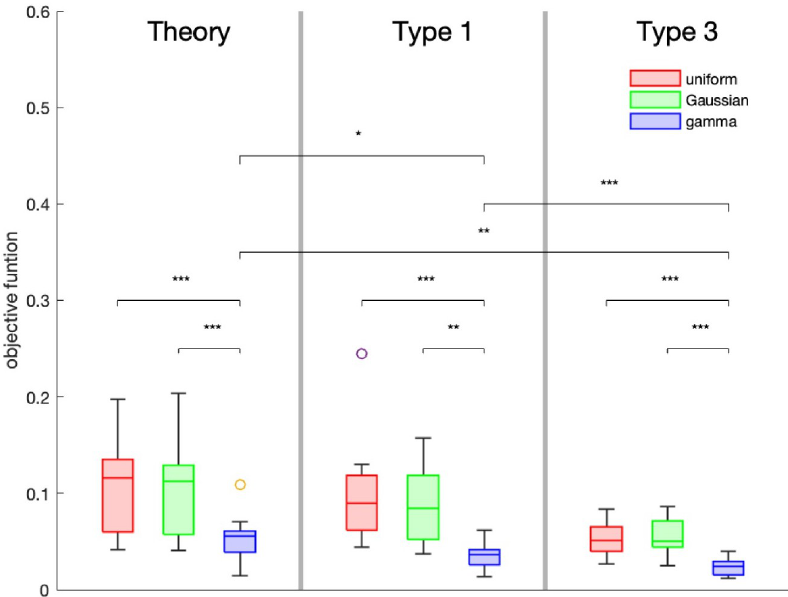
Fig 7. Comparison of how well the different types of simulations fit the experimental data. The results of the optimization are shown. The box color indicates velocity distribution used: red—uniform, green—Gaussian, and purple—gamma. The line in the box gives the average of the objective function, E for the best fit (out of 30) for each of the 13 data sets, the width of the box shows the upper and lower quartile, and the whisker lengths are about ± 2.7 σ where σ is the standard deviation. The circles are outliers. Using the Wilcoxon signed rank test: � for p < 0.022; �� for p < 0.0012; ��� for p < 0.0005. All possible pair combinations are statistically significant except the 6 possible pairings of Theory uniform, Theory Gaussian, Type 1 Uniform, and Type 1 Gaussian. In addition the difference between Theory gamma vs Type 3 uniform and Theory gamma vs Type 3 Gaussian are not statistically significant. The theory uses Eq (5). Length : Theory—fixed with μ = 10, Type 1 and 3—uniform with μ = 5.025 microns.